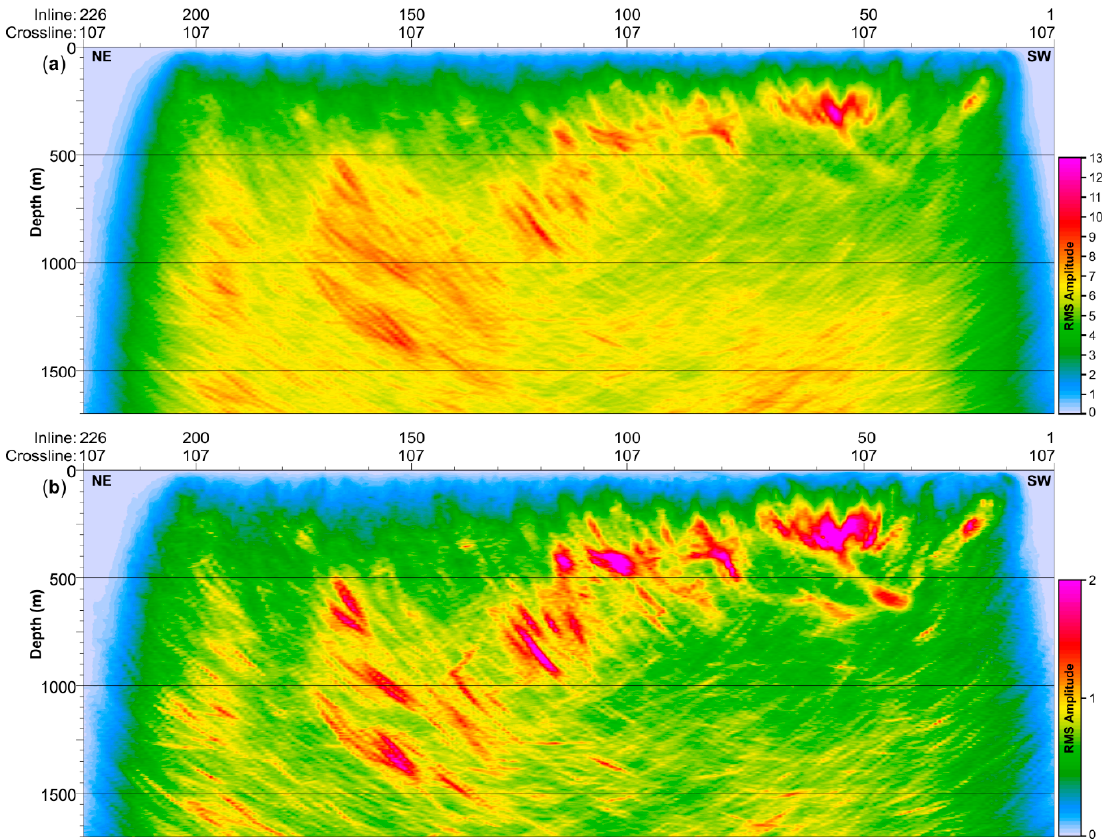
Figure 8. Crossline along the ore zone from the CBFVM run with 5 m vertical sampling using velocity model build with picks corrected with refraction statics and semblance exponent ( a ) p = 1, ( b ) p = 2 (compare with Figure 7b).